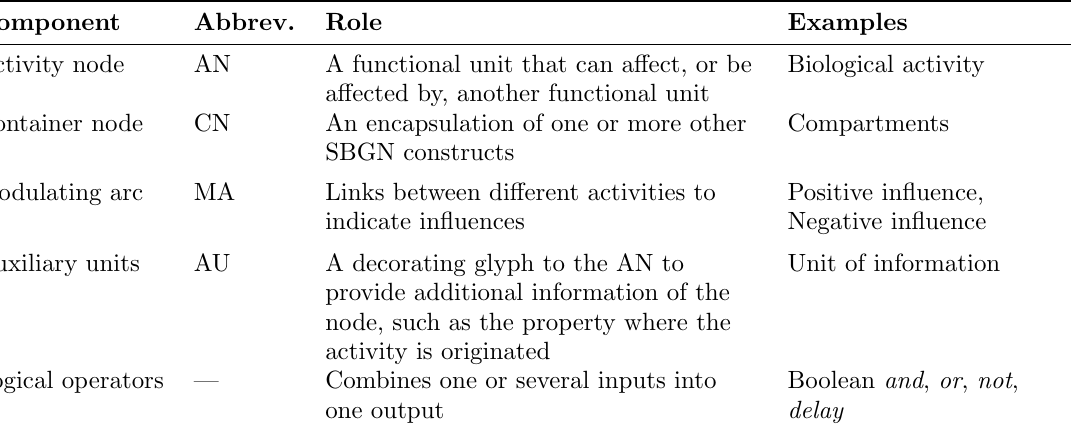
Table 2.1: Summary of Activity Flow components and their